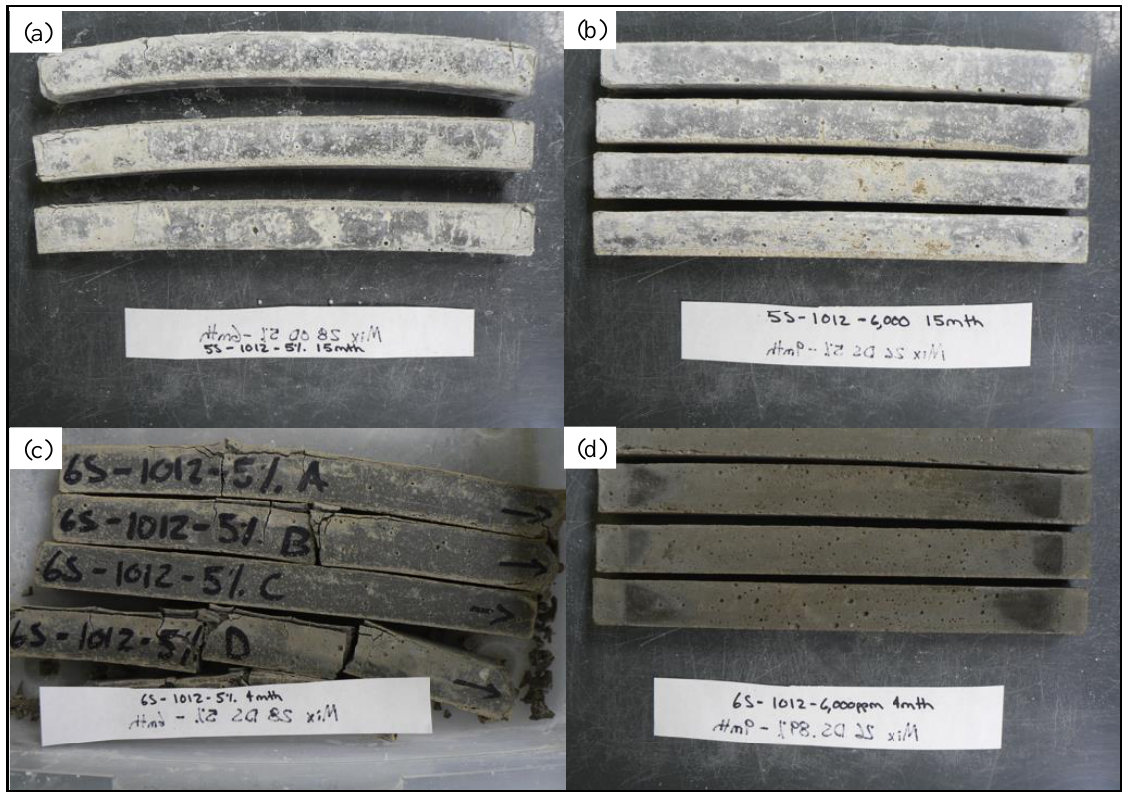
Figure 4. Visual appearance of mortar bars showing deterioration in: ( a ) C2 mixture (5S) in 5% Na 2 SO 4 after 15 months; ( b ) C2 mixture in 0.89% Na 2 SO 4 after 15 months; ( c ) C2 + 30%HC in 5% Na 2 SO 4 around 4 months; and ( d ) C1 + 30%HC in 0.89% Na 2 SO 4 at 4 months.